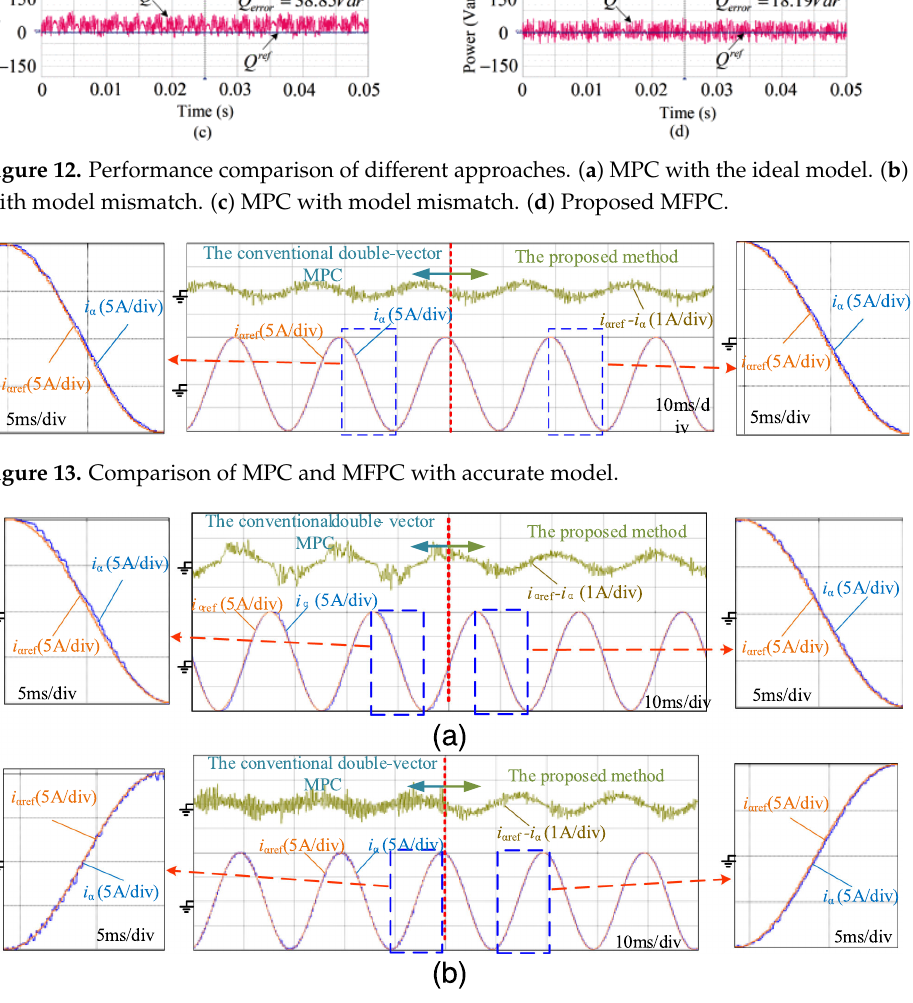
Figure 14. Comparison of MPC and MFPC with model mismatch. ( a ) MPC with model mismatch. Fig. 15. Comparison of current errors when the reference current is ( b ) MFPC with model Fig. 15. Comparison of current errors when the reference current is